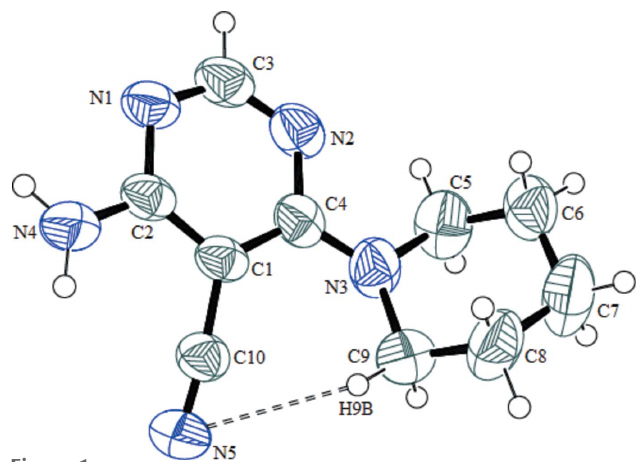
Figure 1 The molecular structure of the title compound with displacement ellipsoids drawn at the 50% probability level. The short C—H (cid:3)(cid:3)(cid:3) N contact is indicated by a double-dashed